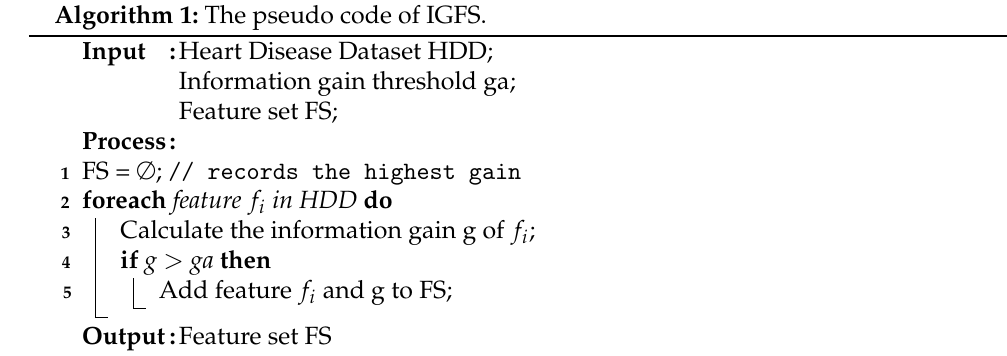
Algorithm 1: The pseudo code of